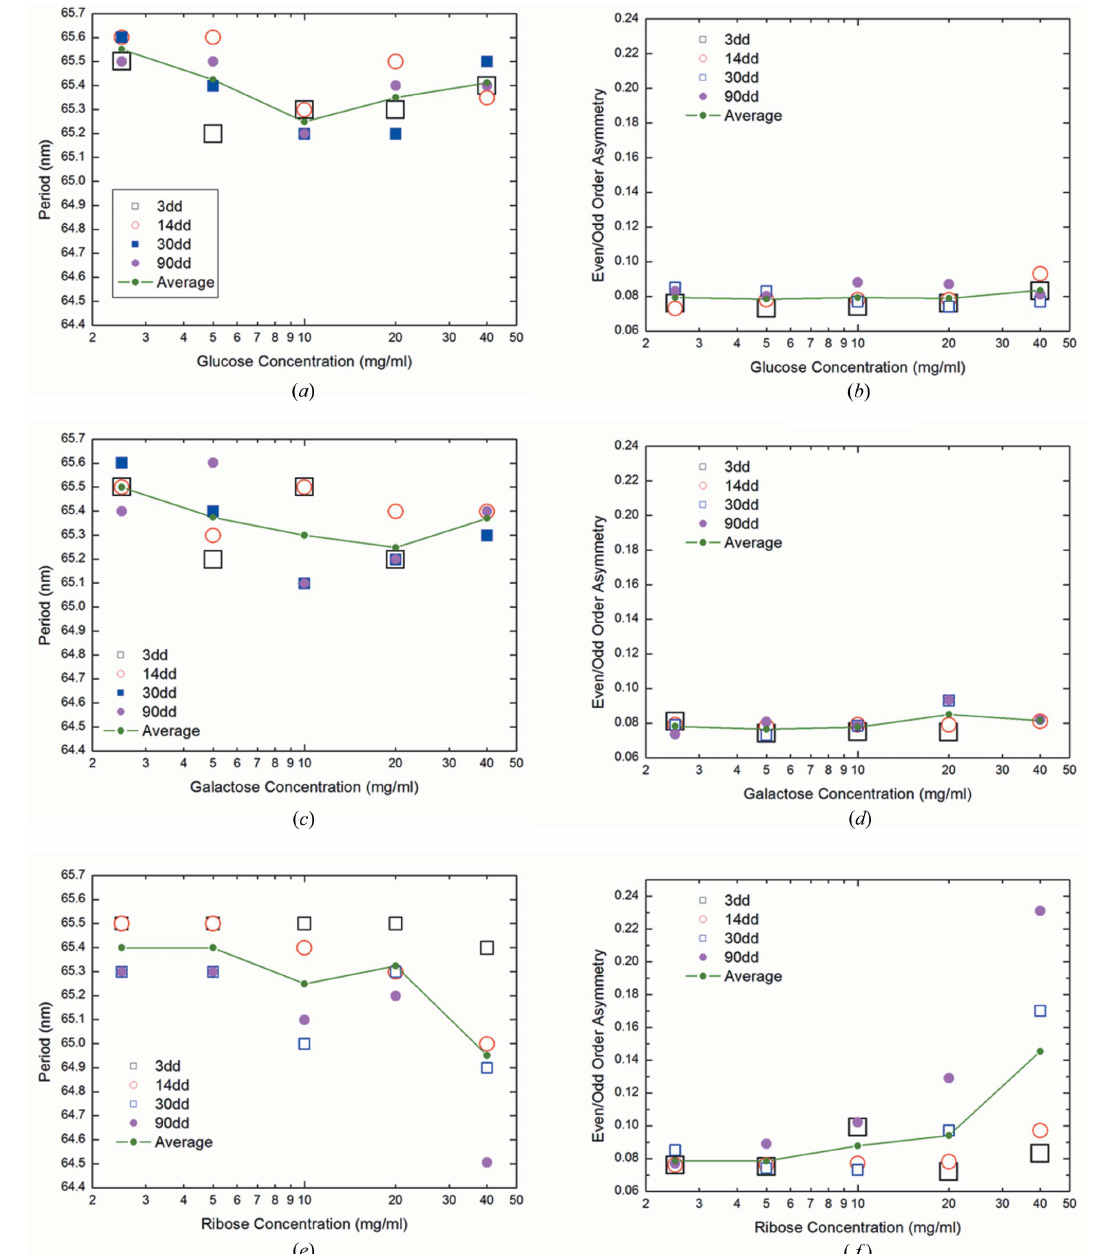
Figure 3 Periodicity along the axial direction determined in a model-dependent fit for glucose ( a ), galactose ( c ) and ribose ( e ), at increasing concentration and different incubation times. Asymmetry values of the nanoscale axial electron density for glucose ( b ), galactose ( d ) and ribose ( f ), at increasing concentration and different incubation times. The symbols correspond to fits of I ( q ) from the average across curves at these